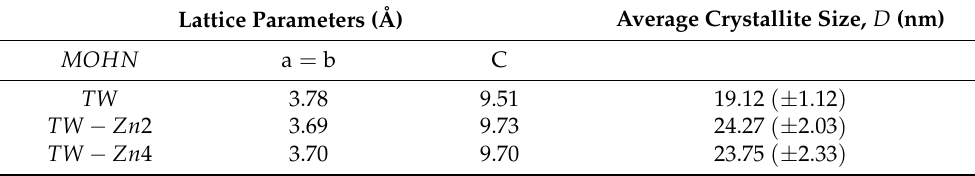
Table 1. Lattice parameters and crystallite size of TiO (cid:2870) in 𝑇𝑊 , 𝑇𝑊 − 𝑍𝑛2 and 𝑇𝑊 − 𝑍𝑛4 𝑀𝑂𝐻𝑁 . Lattice Parameters ( Å )